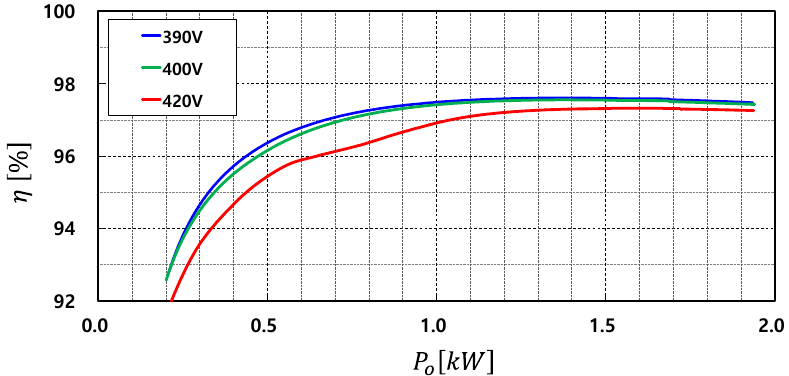
Figure 22. Measured power conversion efficiency of the experimental circuit.